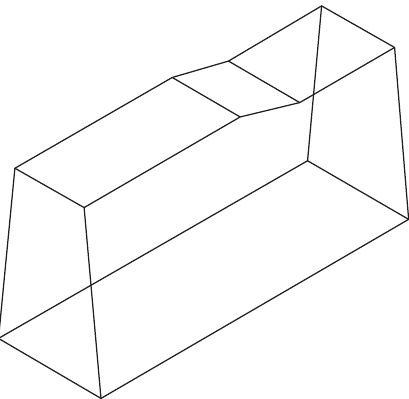
Figure 2: The simplified model of the